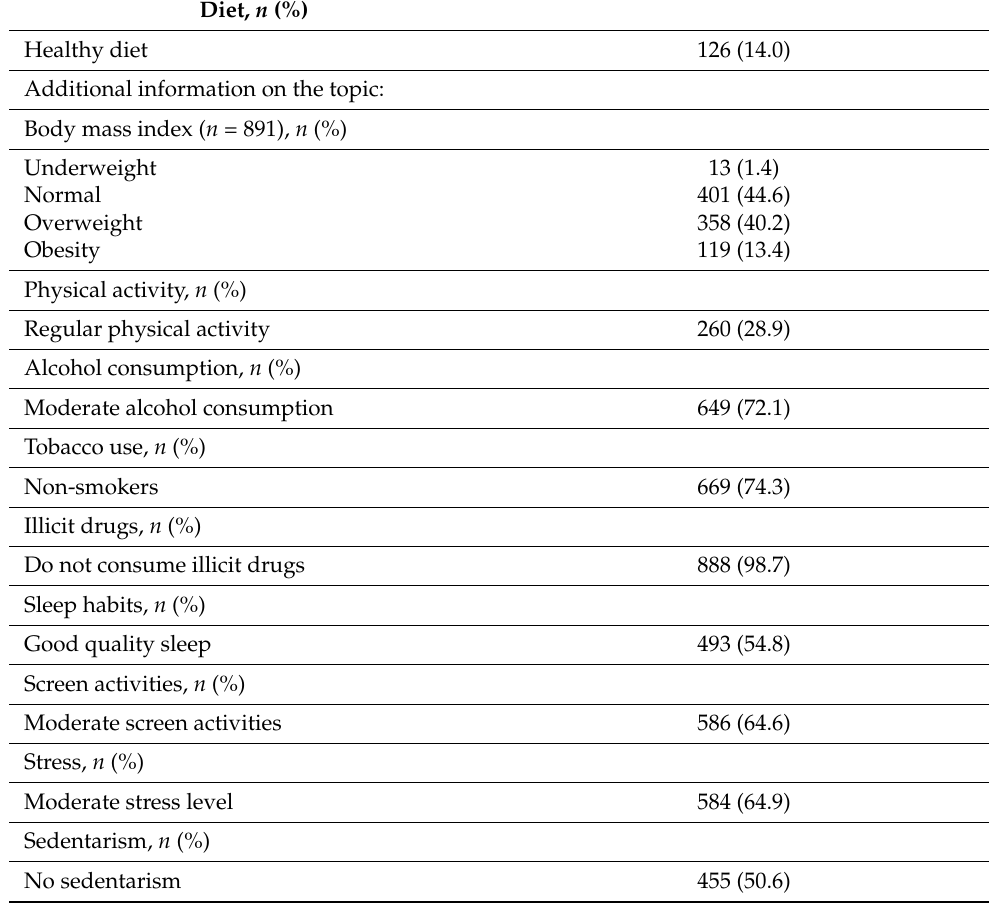
Table 4. General characterization of the participants’ lifestyle